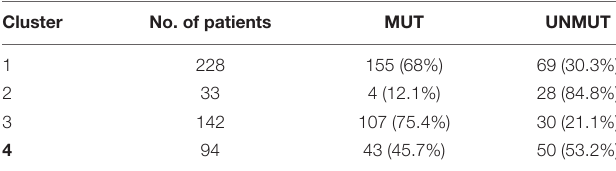
TABLE 3 | Distribution of IGHV somatic hypermutation status among the identified clusters.